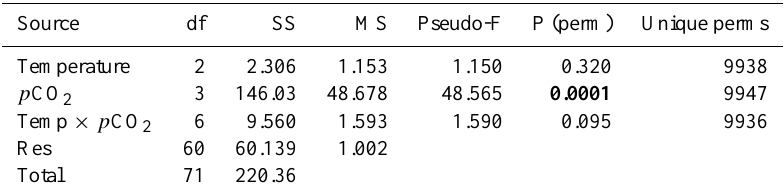
Fig. 7. MDS ordination of shell degradation categories with labels for the two-way crossed design: analyses of raw scores for each category ( a to e ) and of the compound value of all categories (f) . 2-D stress is the goodness of the representation, i.e. a stress of < 0.05 gives an excellent representation with no prospect of misinterpretation. Table 3. PERMANOVA using all five shell degradation categories as response variables indicating the effect of temperature and p CO 2 on shell degradation. Significant results are represented in